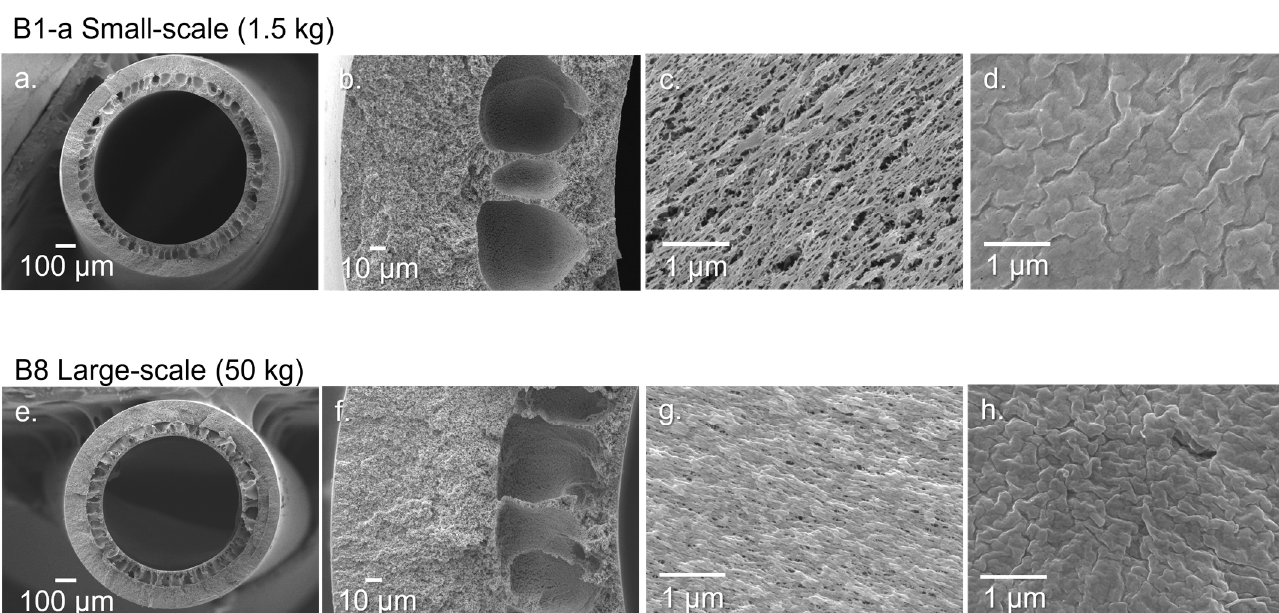
Figure 4. FESEM of PVDF hollow fiber membranes. ( a , e ) Cross-section of membrane; ( b , f ) zoom-in of membrane’s cross-section; ( c , g ) inner surface of membrane; ( d , h ) outer surface of membrane.